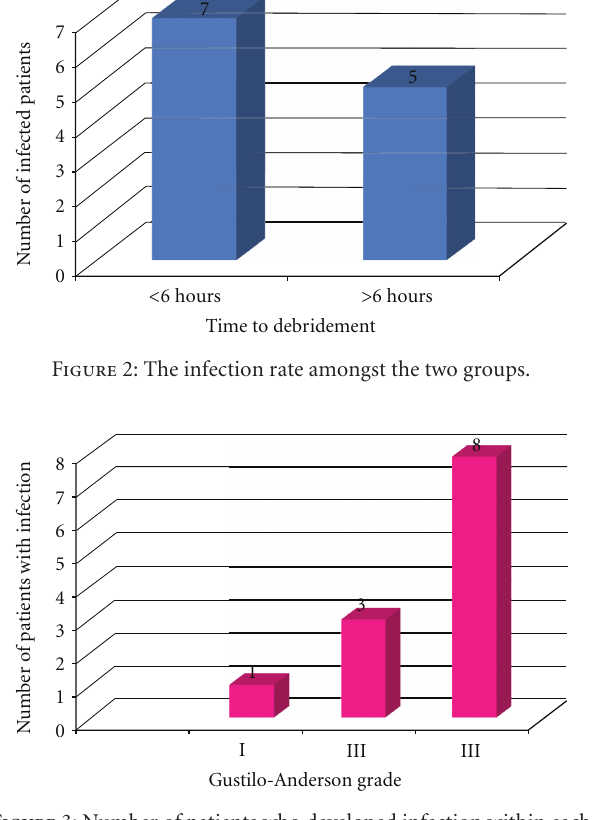
Figure 3: Number of patients who developed infection within each Gustilo grade. Table 1: Stratification of infected cases stating distribution with regard to Gustilo-Anderson classification and time to debridement of each individual